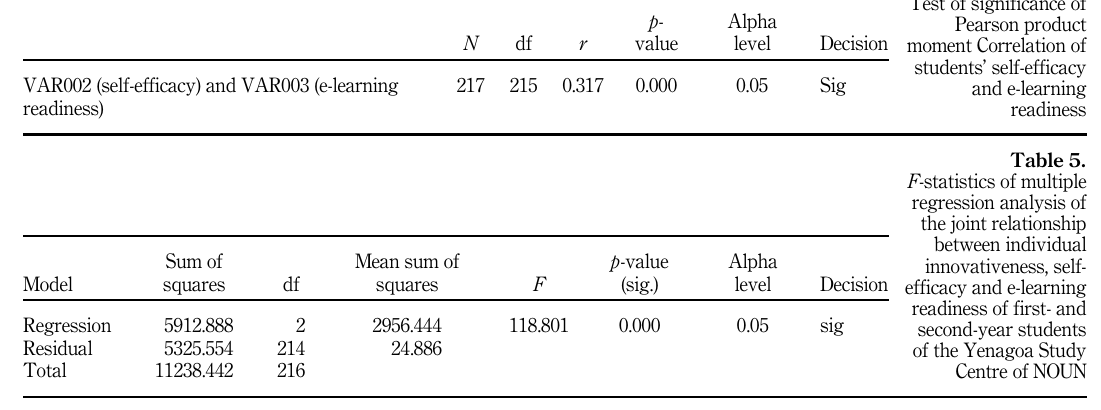
Table 4. Test of significance of